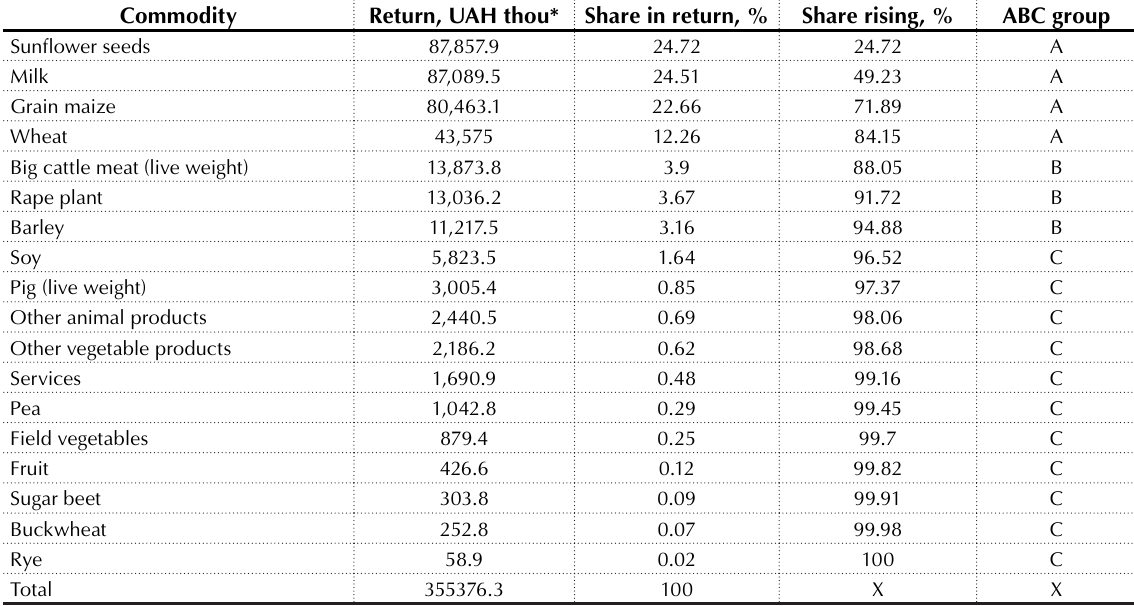
Source: Calculated based on the Statistical Yearbook of